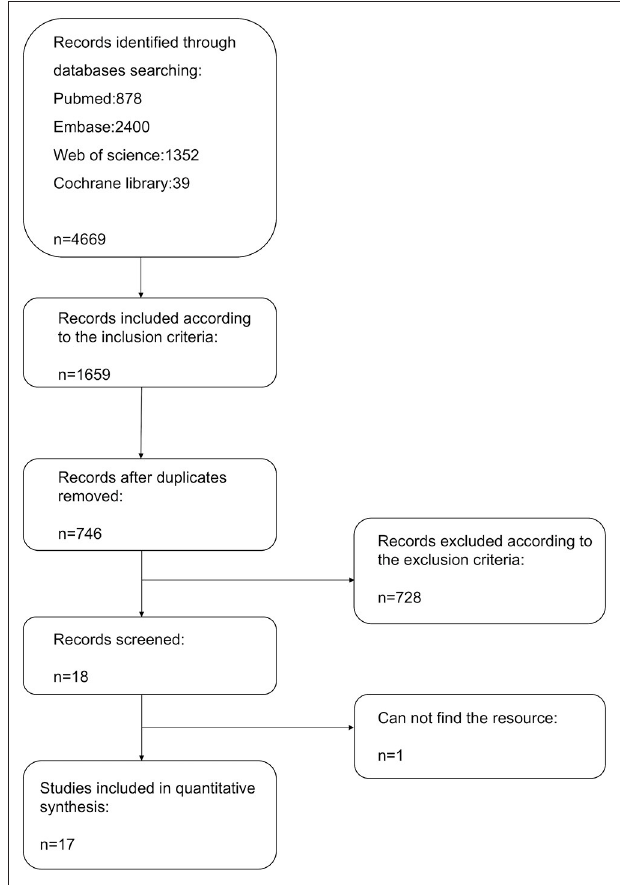
FIGURE 1 | Flow diagram of the study selection